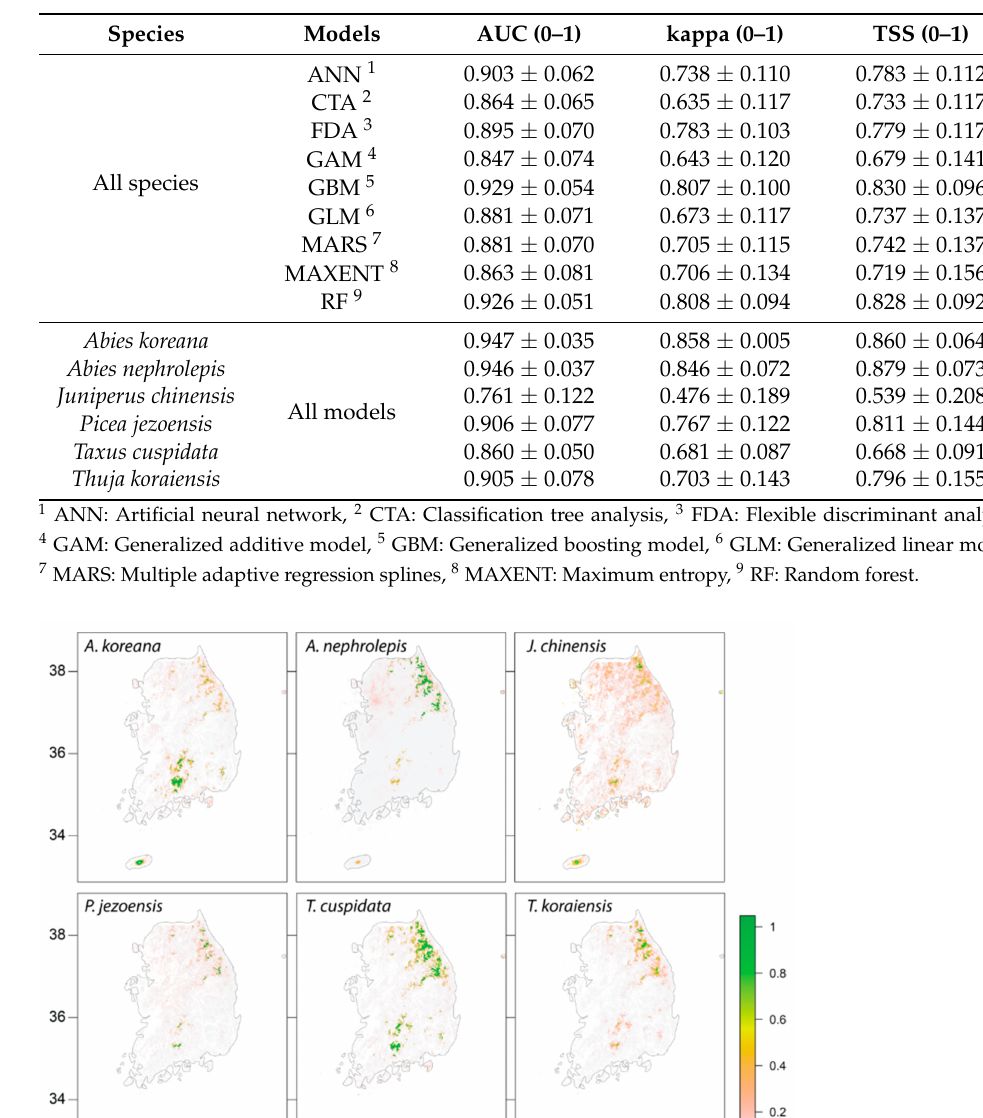
Table 3. Mean and standard deviation of model accuracy under area under the receiver operating characteristic (AUROC), kappa, and true skill statistic (TSS) for the species distribution model and each species.